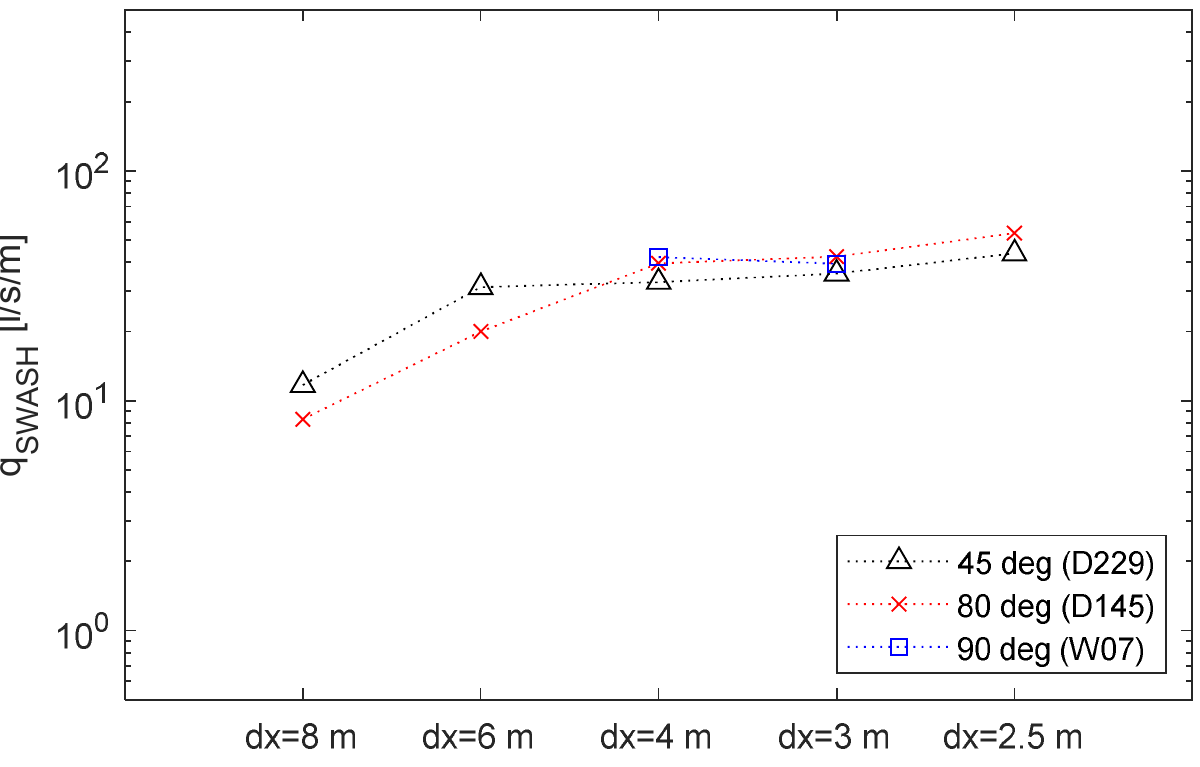
Figure 5. The mean overtopping discharges with different grid sizes (dx = 2.5 to 8 m) for different wave directions (45, 80 and 90 degrees) to check the grid conversion. Directions of 45 and 80 degrees are the cases with long-crested waves, while directions of 90 degrees correspond to the cases with short-crested waves.